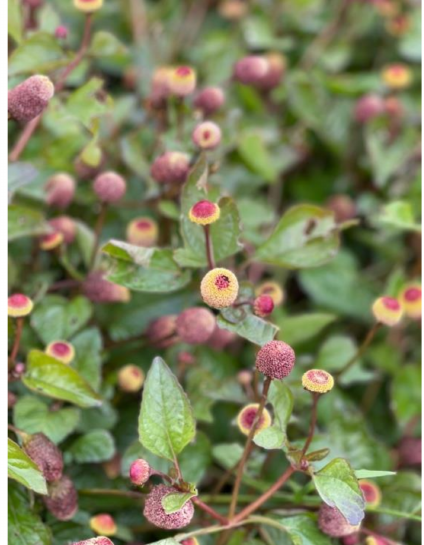
Figure 1. Heads and receptacles of A. oleracea